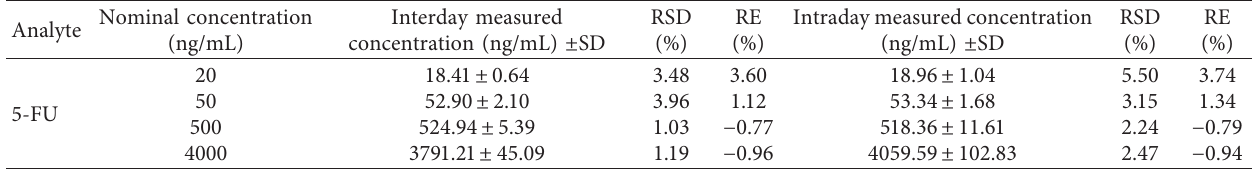
Table 3: Interday and intraday precision and accuracy of 5-FU ( n � 5).